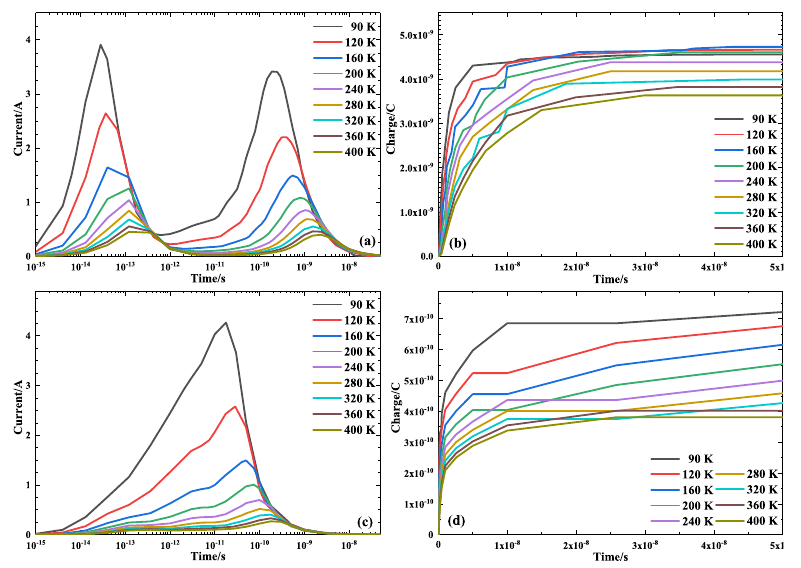
Figure 13. Change in collector current and collected charge with time when heavy ions vertically irradiate the collector ( a , b ) and substrate ( c , d ) of the SiGe HBT under different ambient